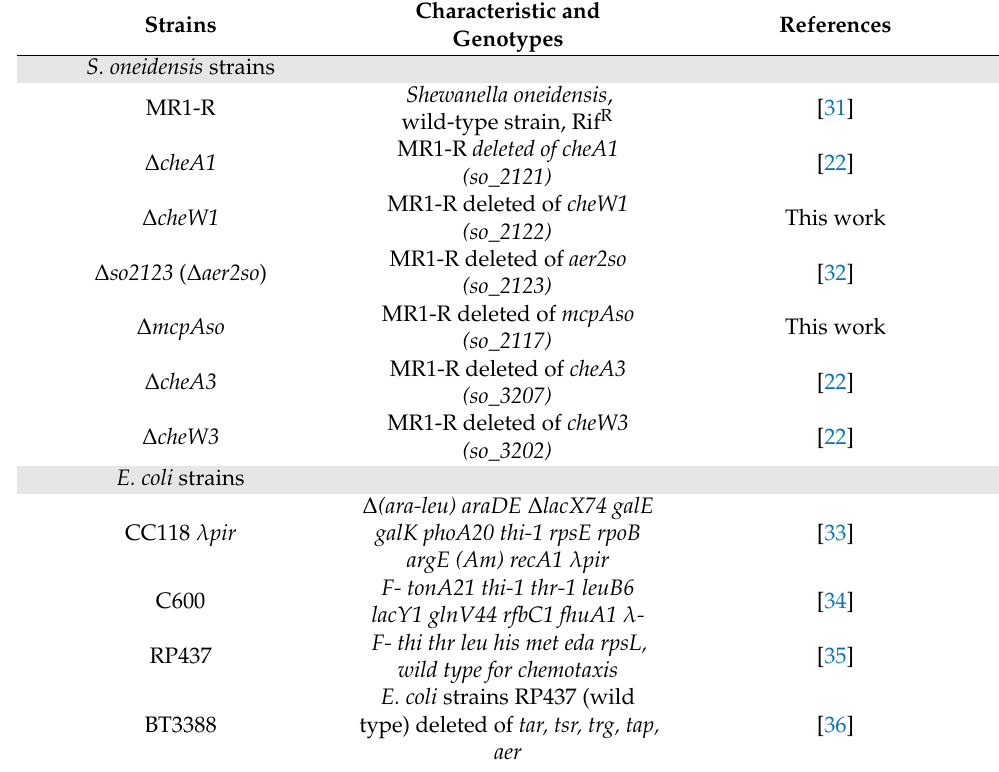
Table 1. Strains used in this